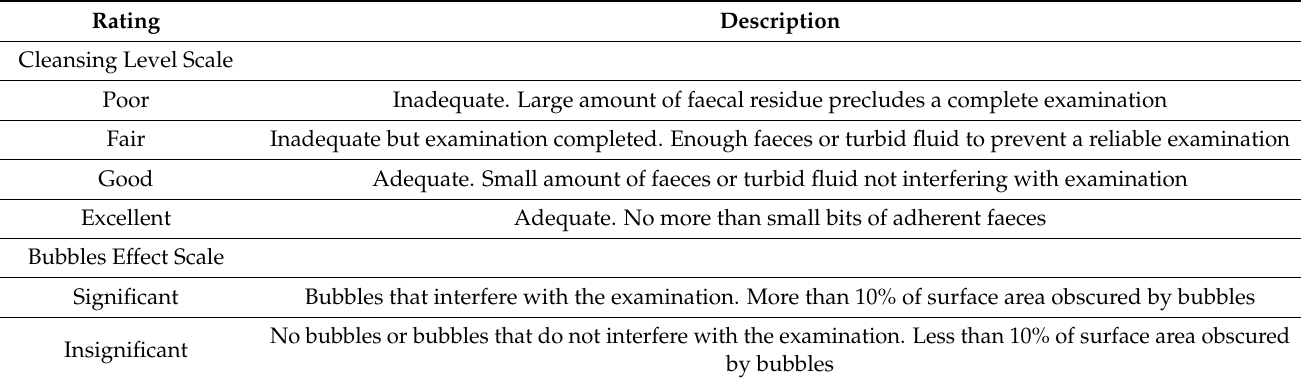
Table 2. Leighton–Rex